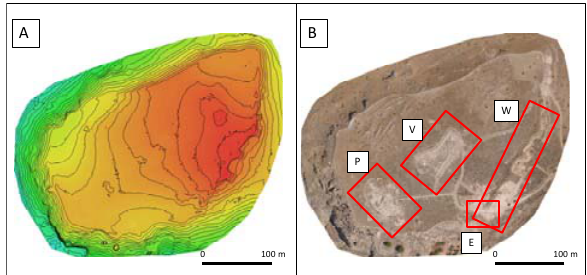
Figure 9. DSM, 10 cm (A) and orthoimage 5 cm (B) of Puente Tablas Oppidum from UAS. Several areas of interest are signalled: Palace (P); Village (V); Gate (E); Walls and bastions (W).